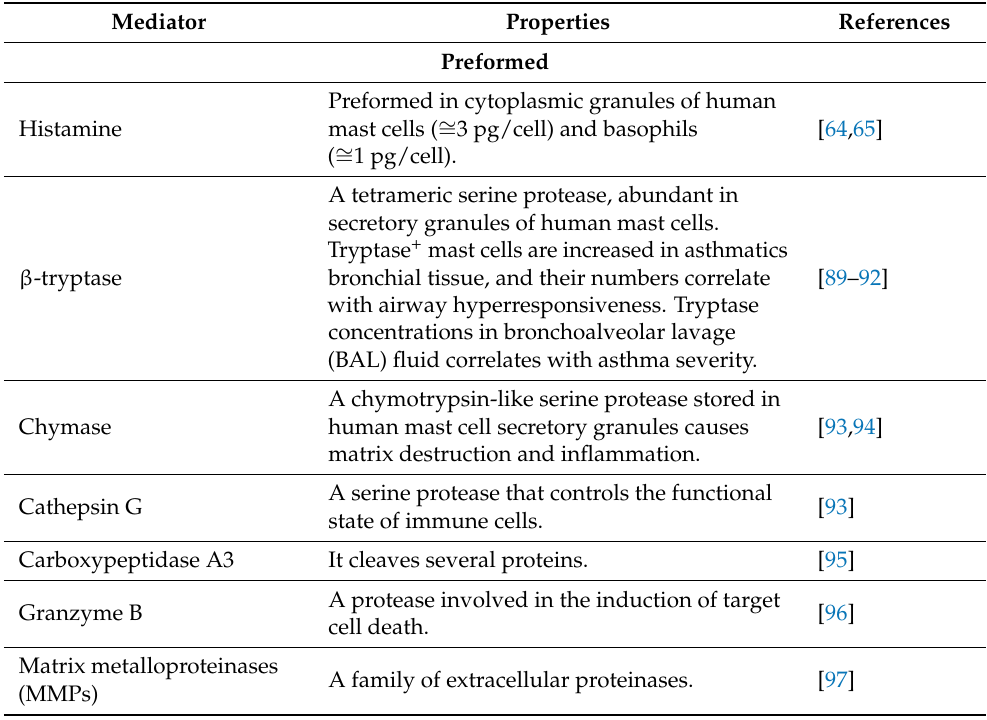
Table 1. Preformed and Newly Synthesized Mediators Released by Human Lung Mast